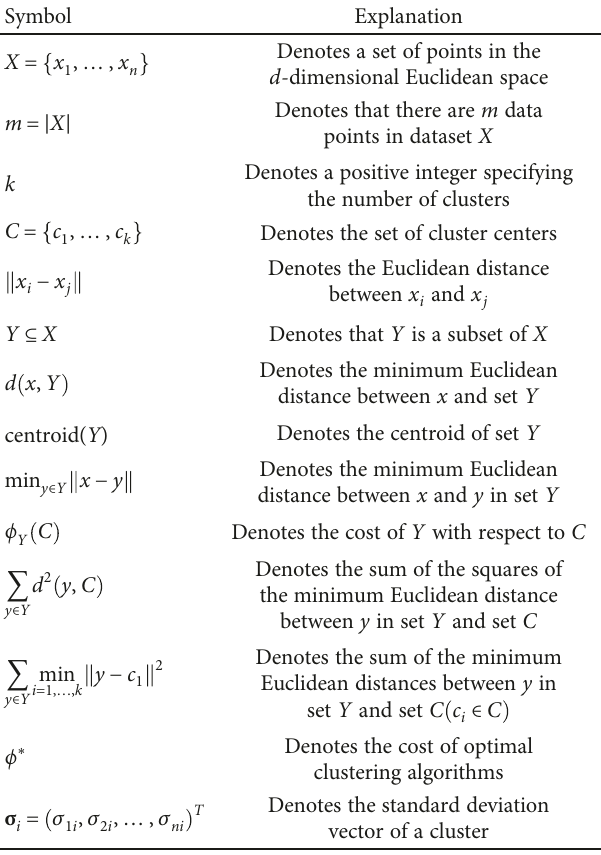
Table 1: Mathematical